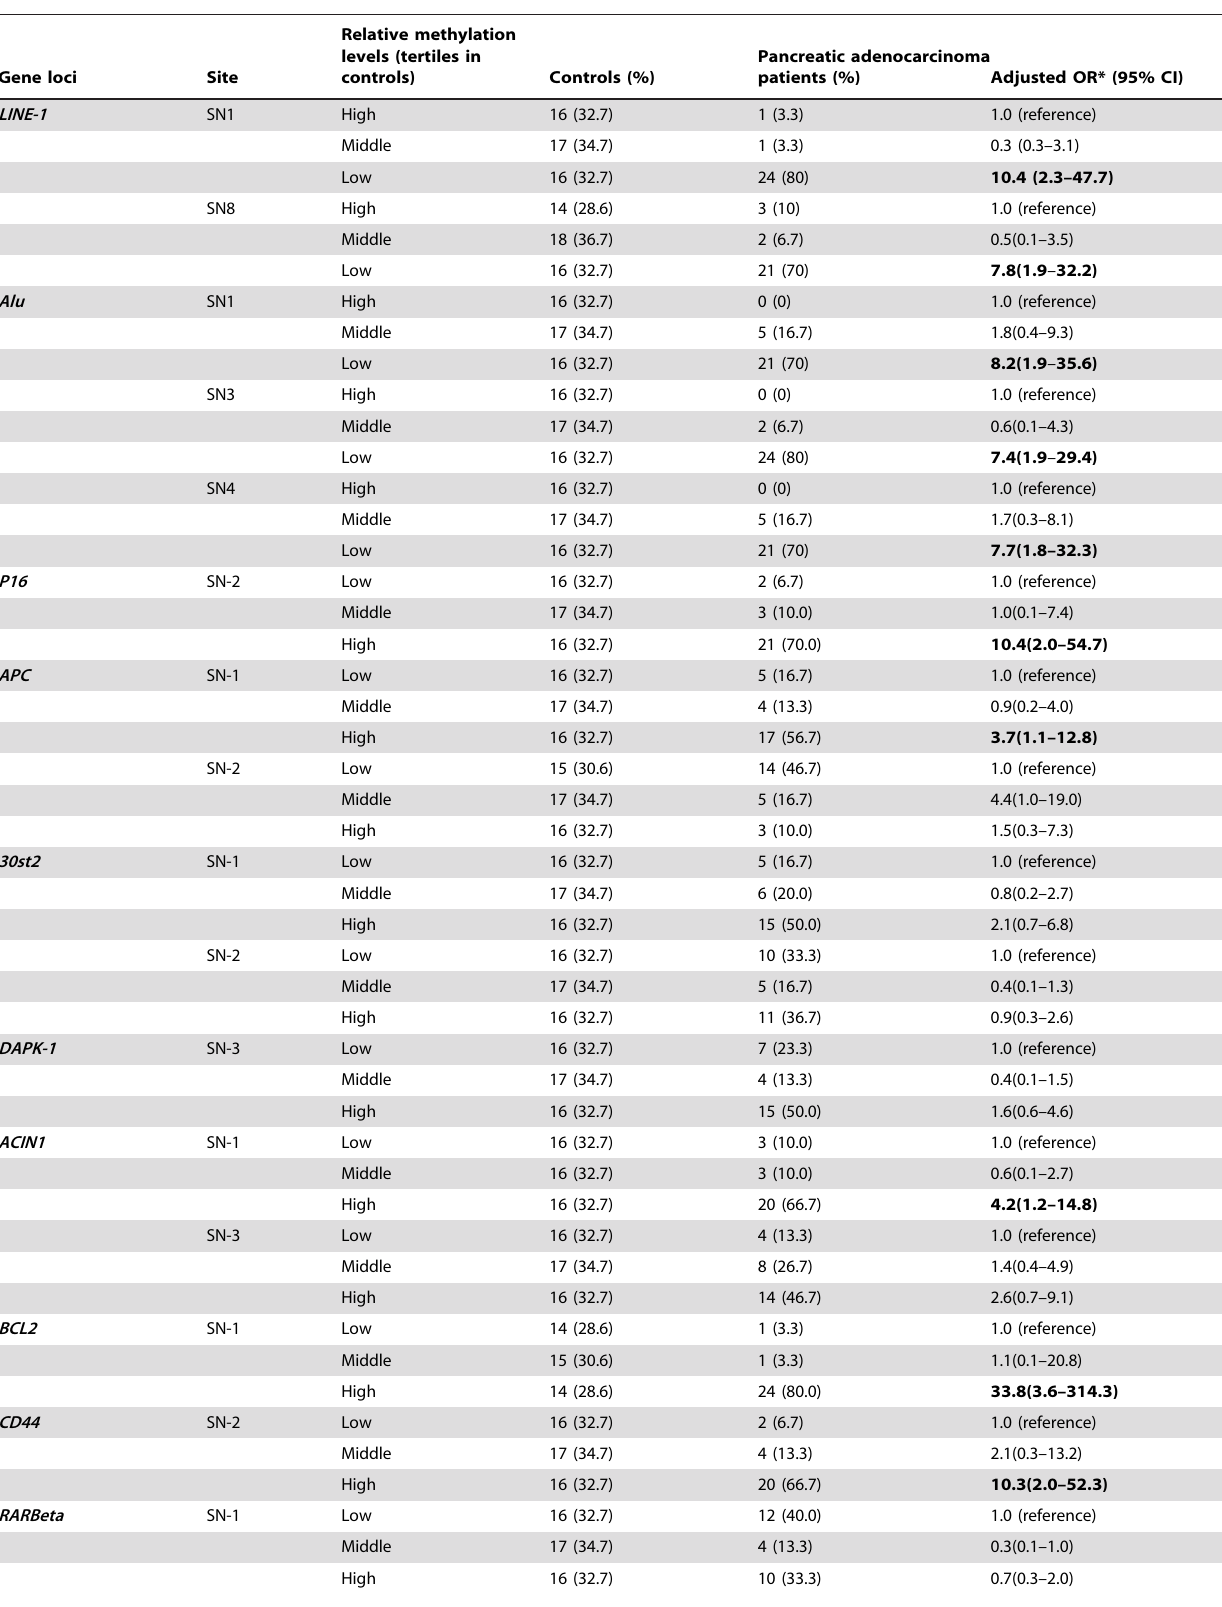
Table 3. Blood-derived DNA relative methylation is associated with the presence of pancreatic ductal adenocarcinoma in patients.